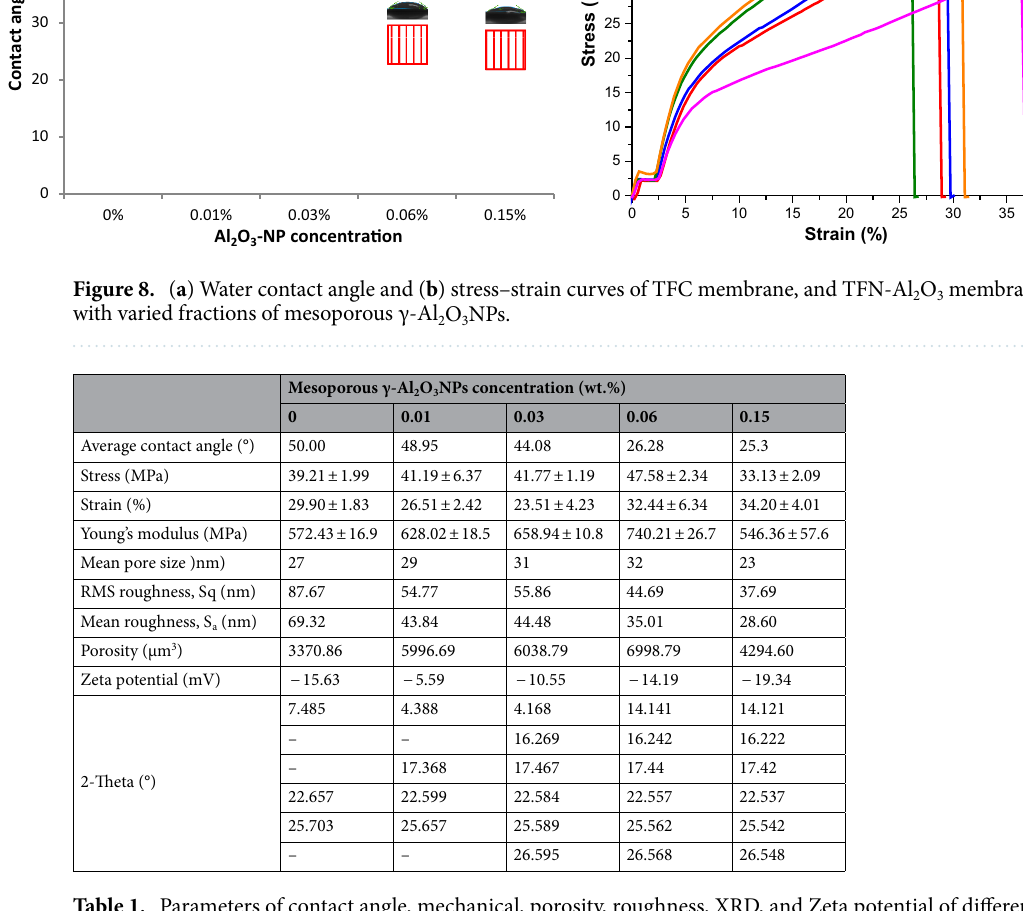
Table 2. The peaks in the XRD profile of the TFC membrane are attributed to the semicrystalline polyester fabric support 61 . As can be noted, the diffraction peaks from the γ-phase of Al 2 O 3 NPs cannot be seen. Additional dif- fraction peaks appeared in TFN-Al 2 O 3 membrane spectra (Fig. 7b,c,d), with intensities increasing with increasing contents of mesoporous γ-Al